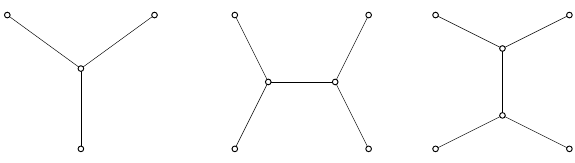
Figure 1 . General tree.